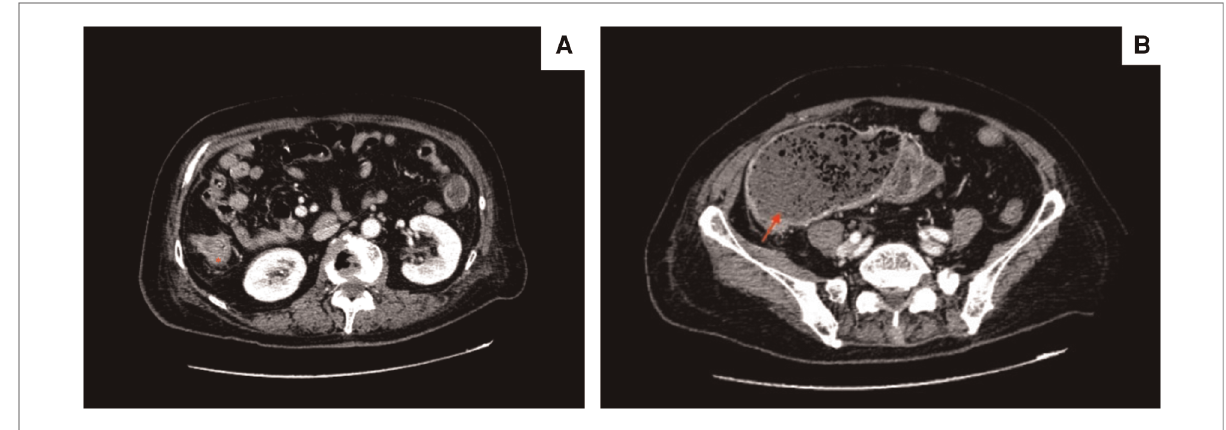
FIGURE 1 Ct scans showing ( A ) irregular thickening of ascending colon wall (marked by asterisk) and ( B ) proximal intestinal bowel distension (red arrow).